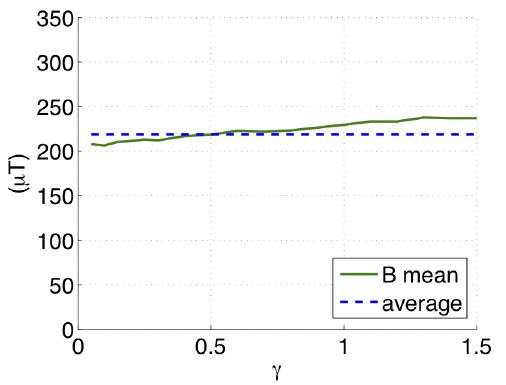
Figure A5. Mean magnetic flux density in the ferrite versus the scaling factor for ferrite thickness proportional to γ 2